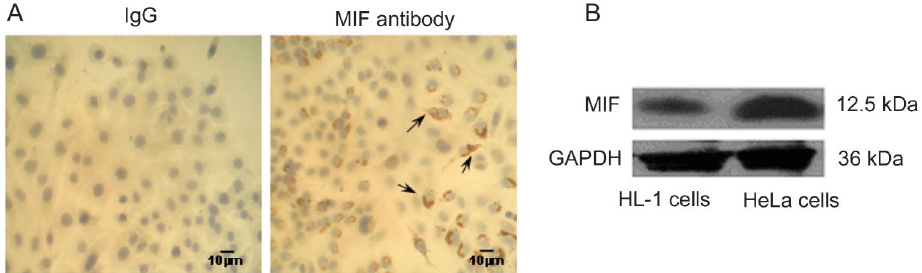
Figure 1. Expression of macrophage migration inhibitory factor (MIF) in HL-1 cells. A , Representative examples of immunohistochemical analysis of HL-1 cells. MIF expression in HL-1 cells with positive cytoplasmic staining (arrows). The staining specificity was tested by substituting IgG for the primary antibody. B , Western blot analysis of MIF performed on cell lysates showing a single band of 12.5 kDa.